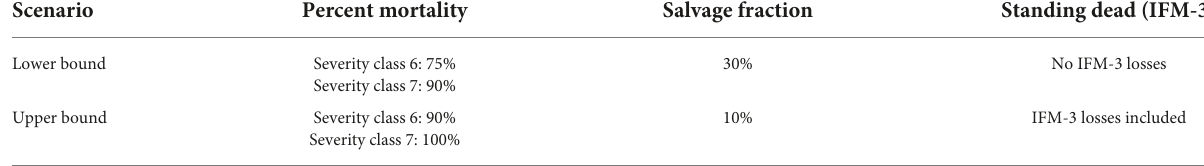
TABLE 2 Wildfire emission estimate